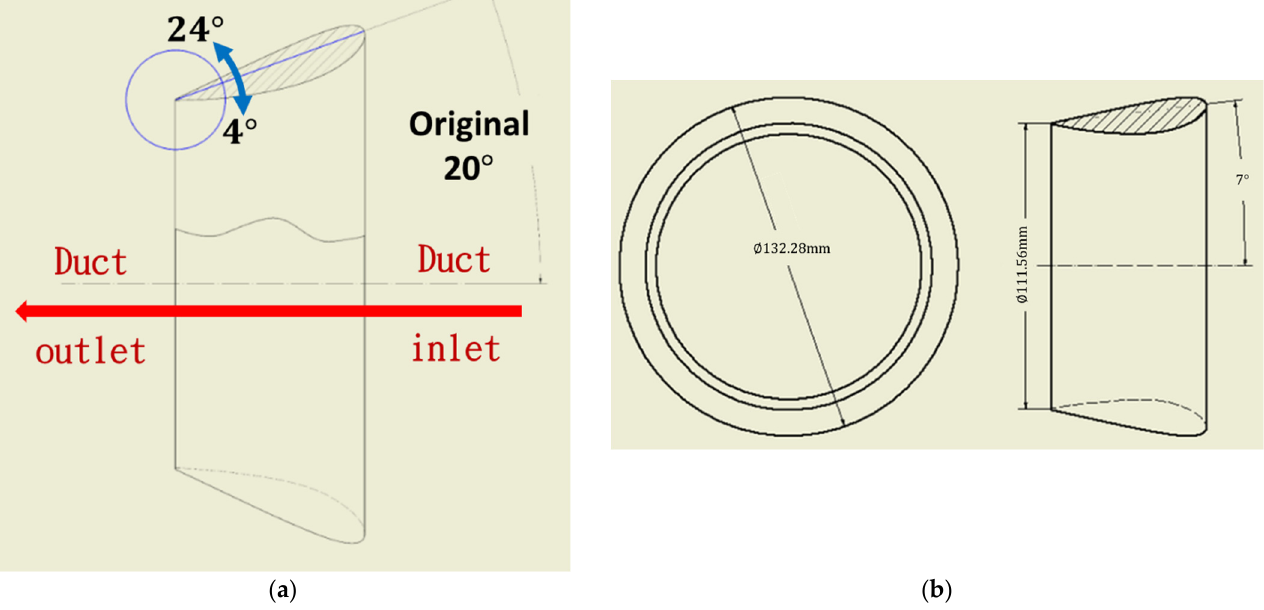
Figure 2. Stern duct design for JBC: ( a ) angles of attack 4–24° for the duct foil section; and ( b ) the optimal stern duct with 7° angles of attack.